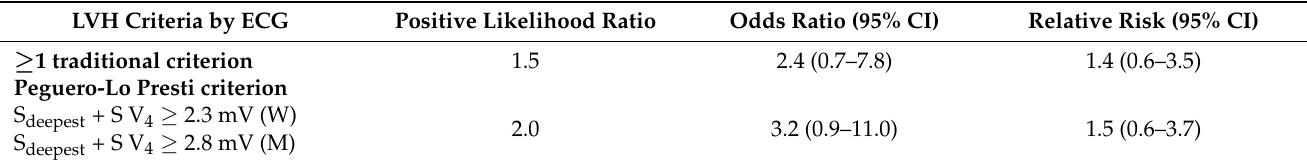
Table 3. Positive likelihood ratio of electrocardiographic LVH in patients with versus without echocardiographic LVH, and odds ratio and relative risk of echocardiographic LVH in patients with versus without any of the traditional ECG- LVH criteria.